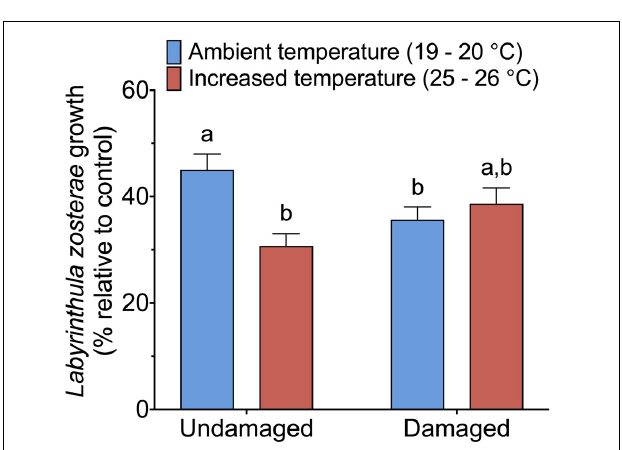
FIGURE 5 | Inhibitory effect of Zostera marina extracts against Labyrinthula zosterae , measured as average L. zosterae growth on extracts of Z. marina shoots exposed to ambient and increased temperature and with damaged or undamaged tissue relative to L. zosterae growth on controls. Different letters above bars indicate significant differences between treatments based on the Student–Newman–Keuls test ( P < 0.05). Only significant results (see Table 4 ) are included in the figure and not all interactions. The non-significant treatments are therefore pooled giving a higher replication than 20 replicates per treatment. Error bars show standard error, n =